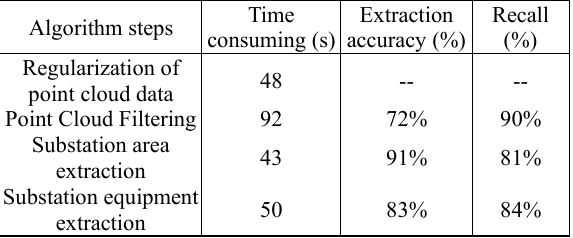
Table 1. The time efficiency in each step of extraction